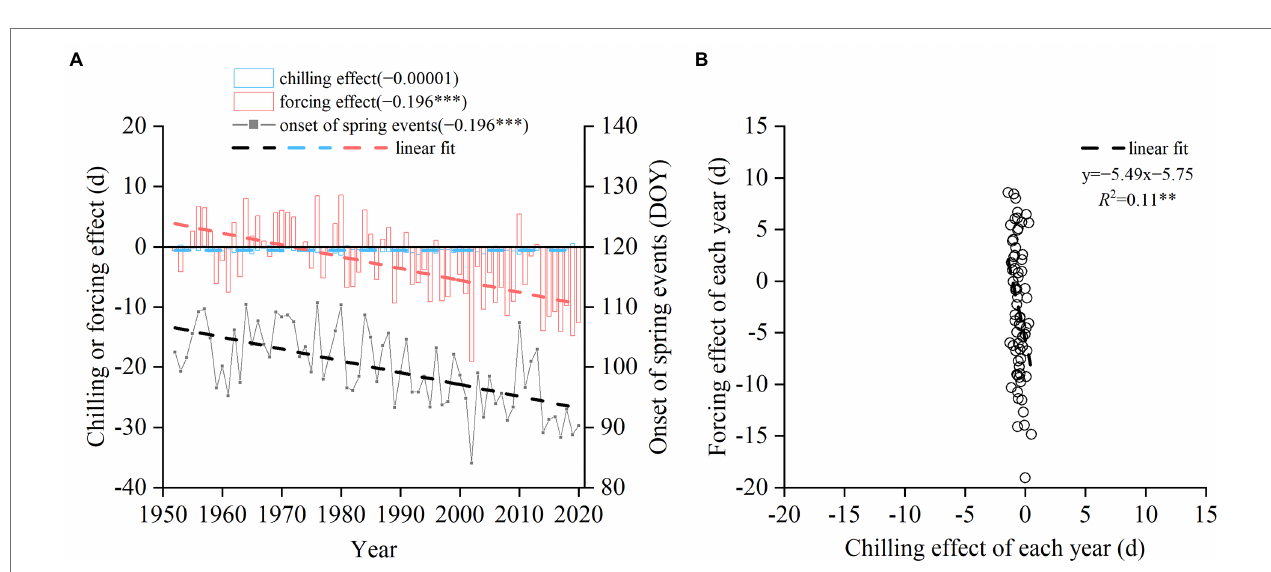
FIGURE 4 | Simulated change in the timing of spring events averaged from 14 woody species from 1952 to 2020. (A) Annual chilling effect, forcing effect, and the onset date of spring events averaged from 14 species. DOY: day of the year. Linear trends are shown in parentheses (days/year). (B) Relationship between chilling effect and forcing effect across years. *** p < 0.001; ** p <